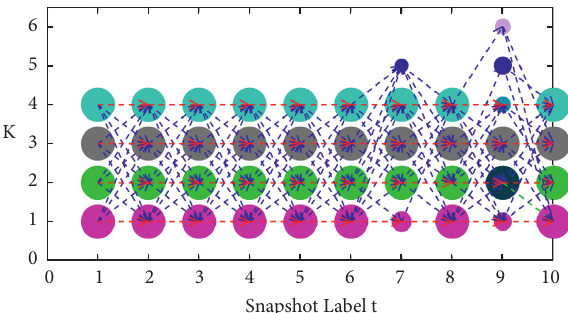
Figure 4: The visualization of the nodes transition among communities at snapshots of Net. 1. Table 3: The comparison results of five methods on Net. 1 − 4.